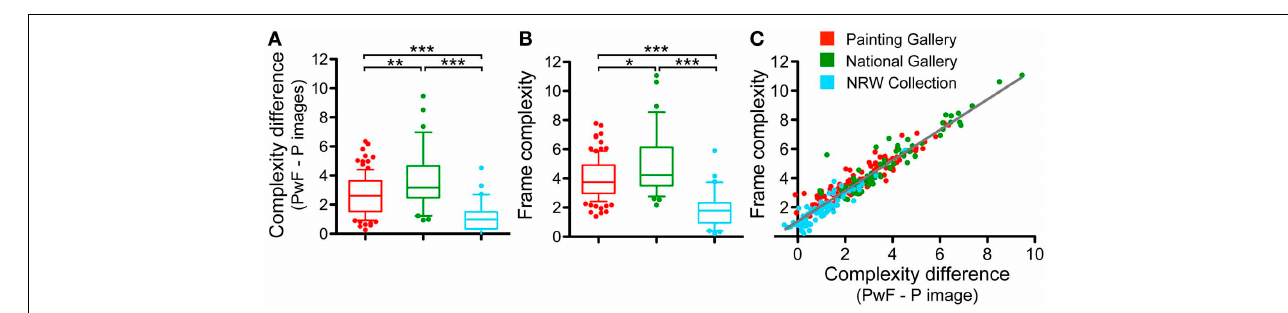
FIGURE 9 | Frame complexity. Two different measures of frame complexity were obtained. First, the complexity difference between the painting with frame and without frame was calculated (A) . Second, complexity of each frame filled by a central area of uniform gray was calculated (B) . Colors represent the different museums, as indicated in (C) . The whiskers represent